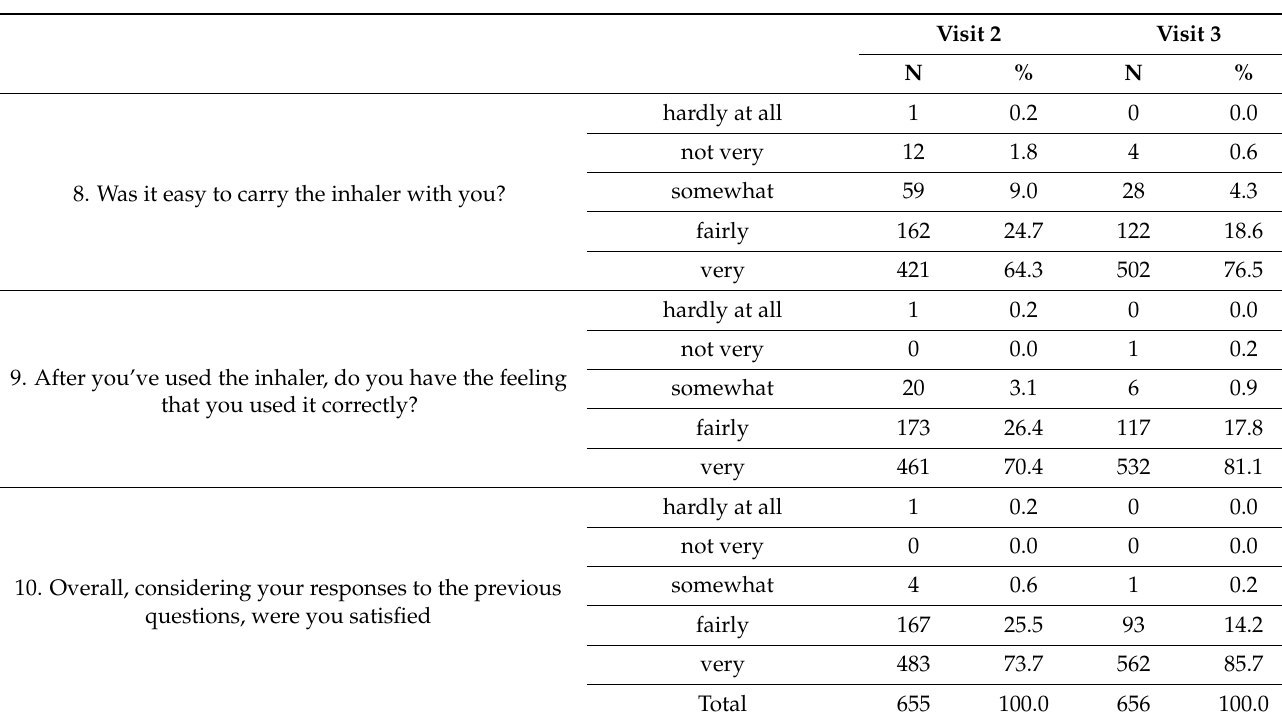
Table 3. Morisky scale: distribution of each of the four items during the two visits after baseline.